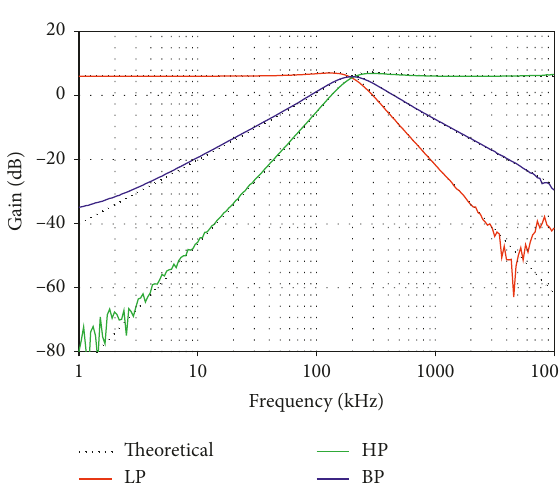
Figure 7: Experiment gain responses of LP, HP, and BP functions.